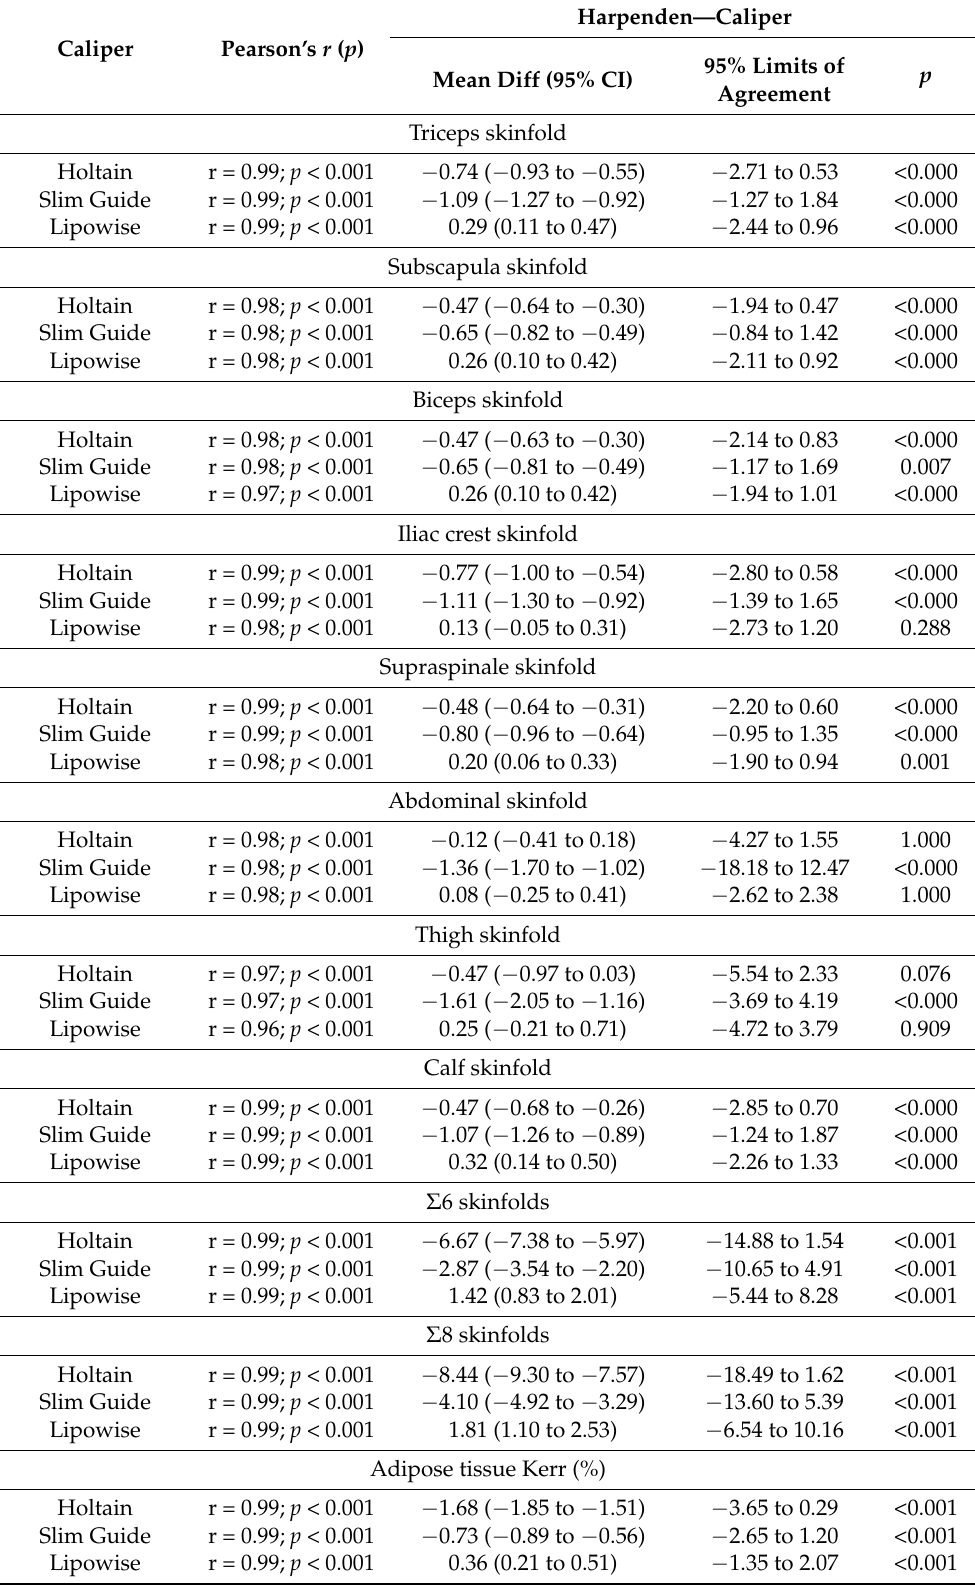
Table 5. Differences between calipers, with respect to the Harpenden caliper and Bland–Altman limits of